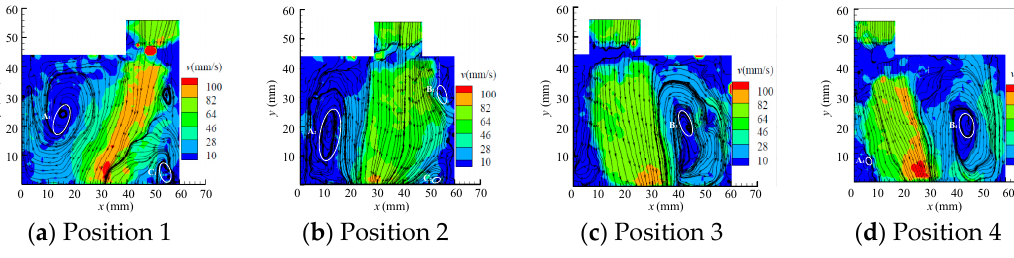
Figure 14. Velocity contours and streamlines with a pump inlet flow of 850 mL/min.